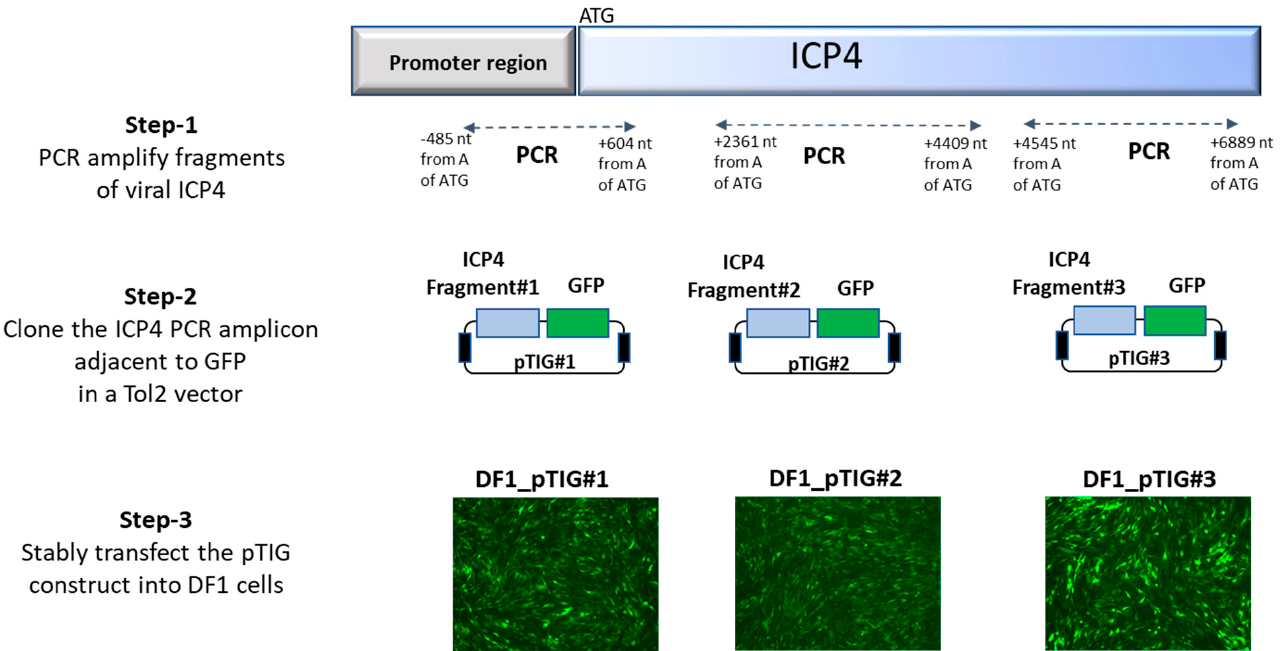
Figure 1. Schematic depiction of generating DF1 cells carrying the infected-cell polypeptide-4 (ICP4) gene fragments and GFP in a Tol2 transposon vector. Three stable DF1 cells carrying the ICP4 and GFP transgenes (DF1-pTIG#1, DF1-pTIG#2 and DF1-pTIG#3) were sorted after 2 weeks post-transfection.